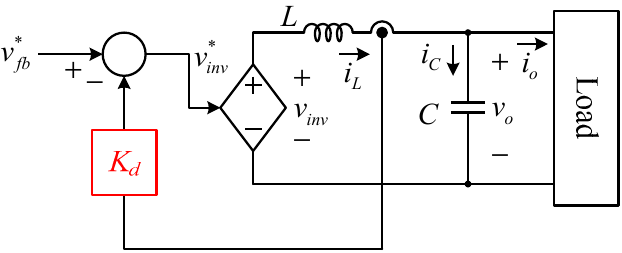
Figure 3. The concept of the active damping control.